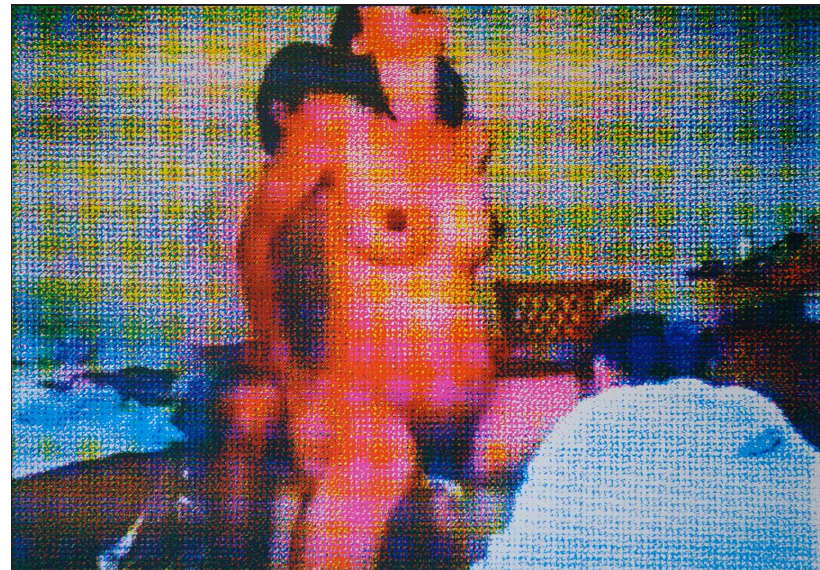
Figure 24: Helen Knowles, A szülés természete (The Natural Way of Birth) <http:// www.youtube.com/watch?v=CH0sRTYd17I> Four colour screen print on Fabriano paper, 101cm x 148 cm ; Edition of 5, Helen Knowles,